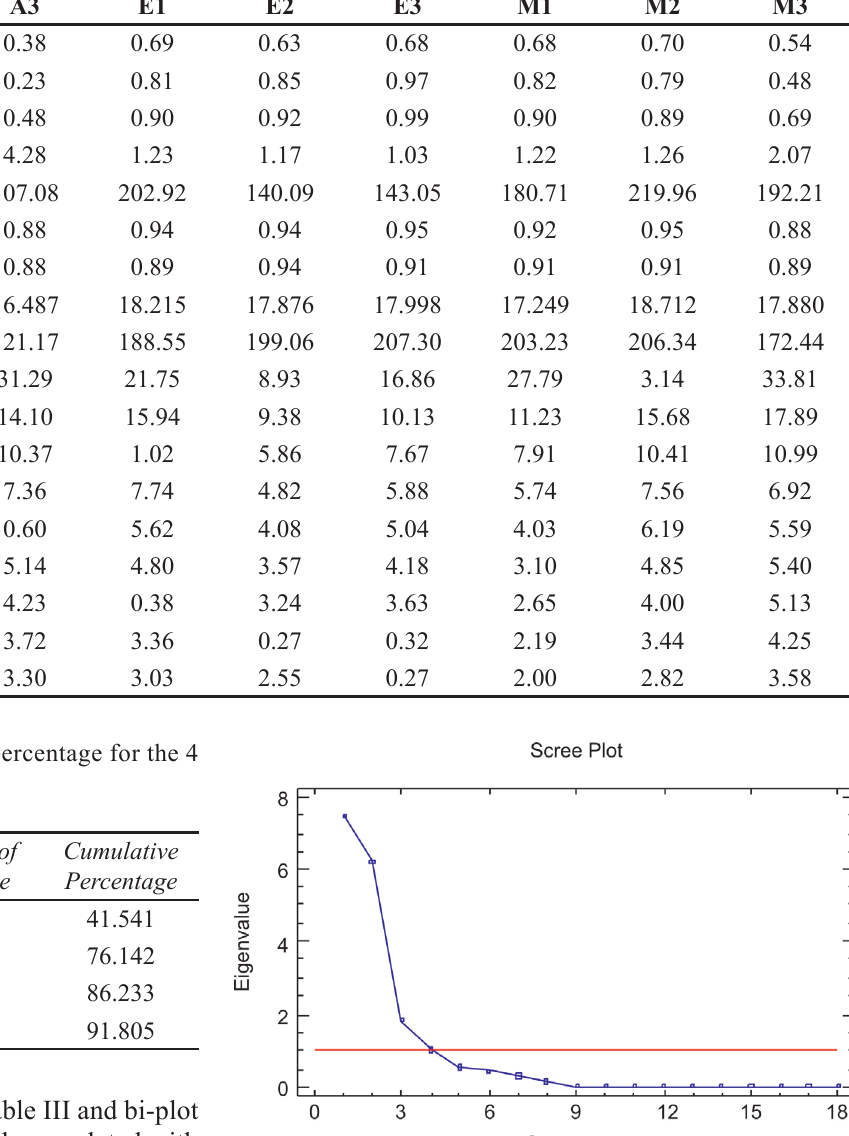
TABLE I - Values of the descriptors of each of the particles: A1, A2, A3 (recrystallized in acetonitrile); E1, E2, E3 (in ethanol); M1, M2, M3 (in methanol) A1 A2 A3 E1 E2 E3 M1 M2 M3 Circul. Round Comp 0.65